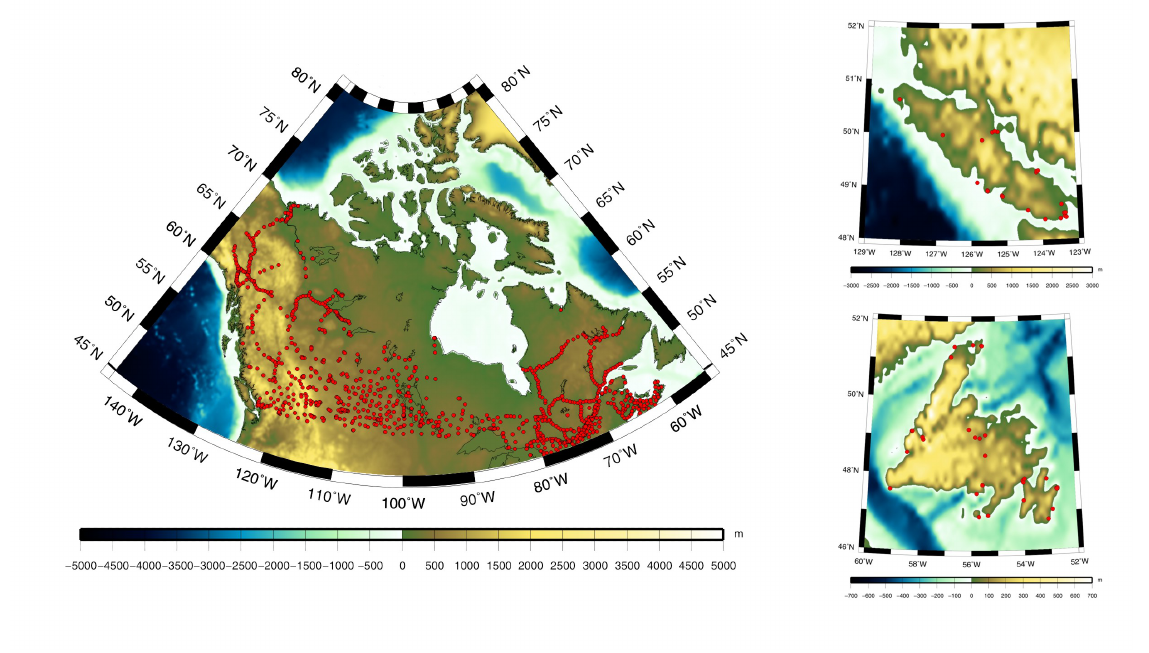
Figure 2. Distribution of Nov07 Benchmarks ( Left: CML Top Right: VAN Bottom Right: